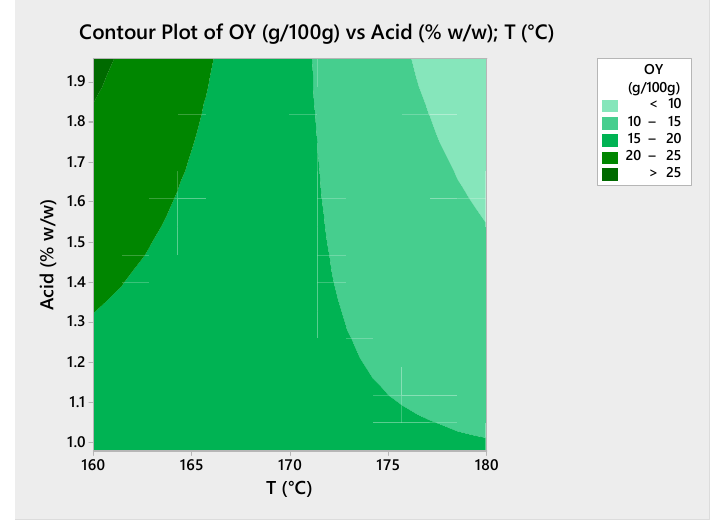
Figure 3. Contour plot of the OY response under different pre-treatment conditions.